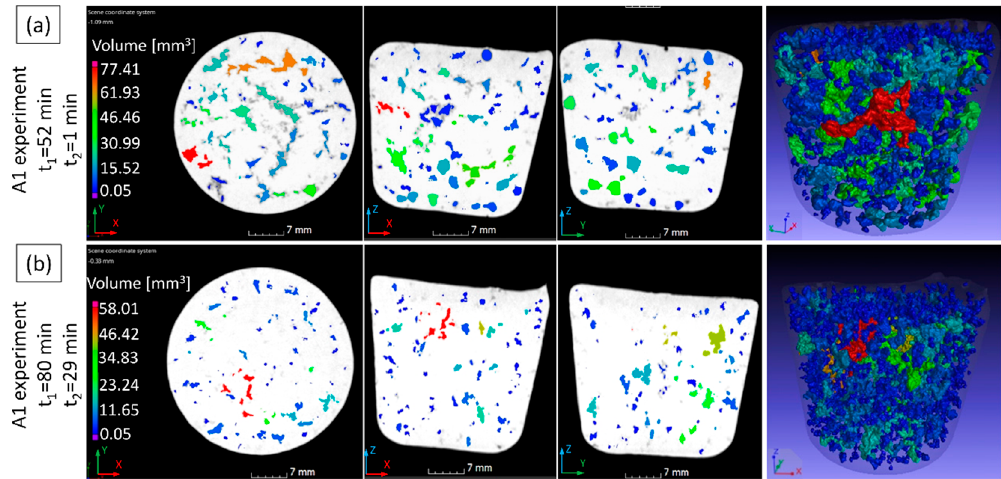
Figure 16. Representative CT sections and volumetric views of the pores detected in the ( a ) first and ( b ) fifth RPT sample cast after Ti-alloying during the A1 experiment.